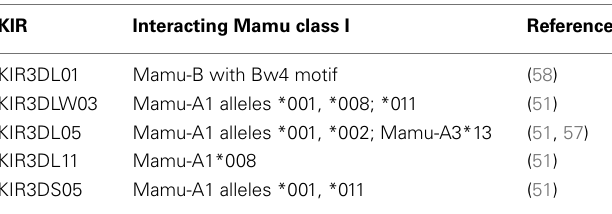
Table 5 | Known interactions of rhesus macaque KIR and MHC class I ligands